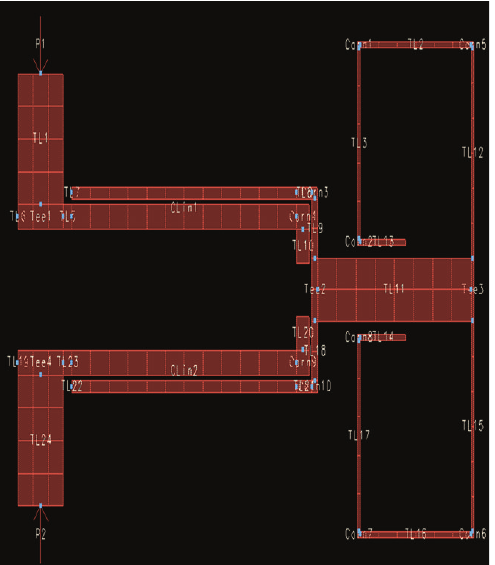
Figure 8: Structure of the broadband band-pass filter designed using a MMR resonator in the workspace of the ADS program.